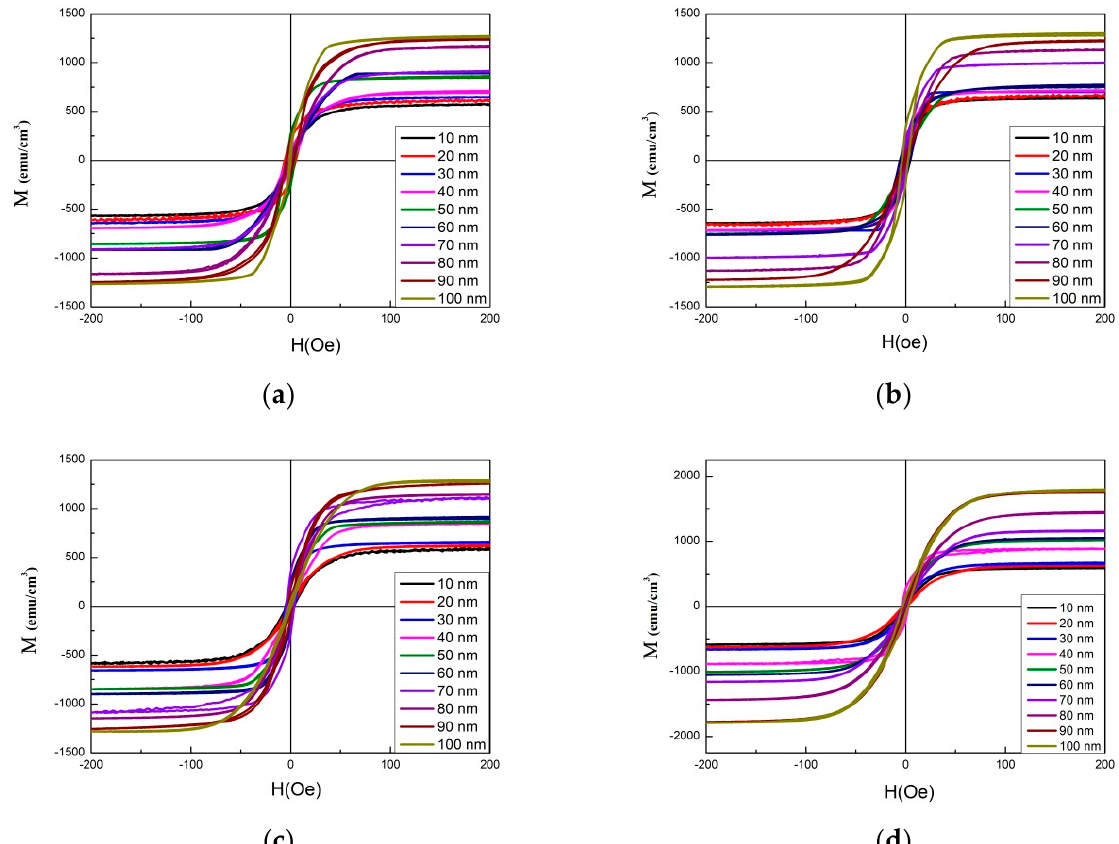
Figure 3. In-plane magnetic hysteresis loop of CoFeWB thin films: ( a ) after annealing at 200 °C, ( b ) after annealing at 250 °C, ( c ) after annealing at 300 °C, and ( d ) after annealing at 350 °C.